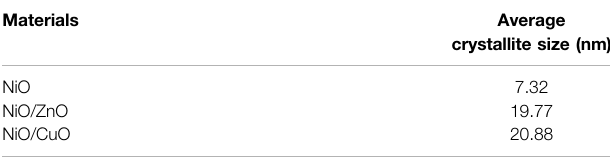
TABLE 2 | Surface area analysis results for NiO-ZnO and NiO-CuO composites.